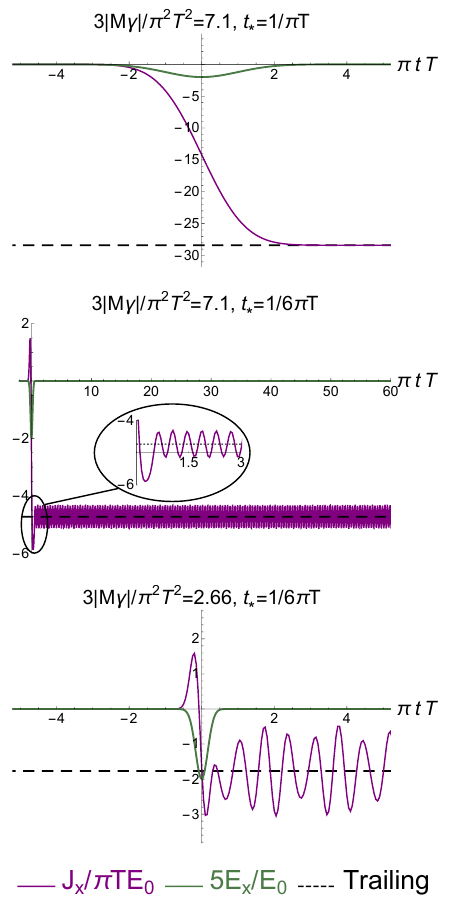
Figure 6 . Plots exhibiting the response of the current J x to a Gaussian disturbance E x of the electric (cid:12)eld. At the top plot the disturbance is too narrow in frequency space to excite the quasi normal modes and a trailing e(cid:11)ect is observed at late times, whereby the current follows the gauge potential and asymptotes to a constant value even though the electric (cid:12)eld has almost vanished. The top and central plots di(cid:11)er in the width of the disturbance of E x . As the Gaussian becomes narrower its Fourier transform has support in a larger region of frequency space and eventually supports the smallest long lived quasi normal mode ! 0 . Note that the oscillations in the central plot are shifted by a constant due to the trailing e(cid:11)ect. On the bottom is a thin Gaussian for a smaller value of j M(cid:13) j =T 2 where two of the long lived quasi normal modes are excited. Following (cid:12)gure 4, at lower magnetic (cid:12)elds the real part of the quasi normal frequencies is closer to the origin. Here too, the oscillations are shifted by a constant due to the trailing e(cid:11)ect. A wider Gaussian at the same value of the magnetic (cid:12)eld can be found in the bottom left plot in (cid:12)gure 1.